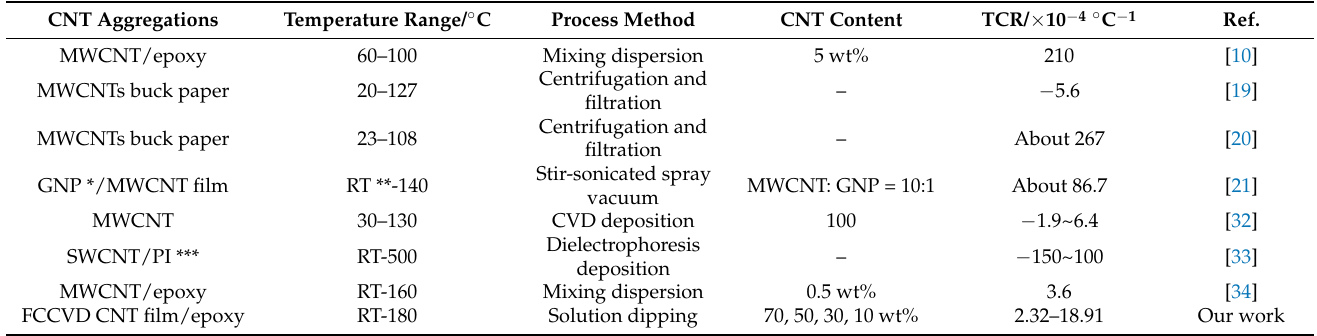
Table 3. Comparison of TCRs of different CNT composite materials